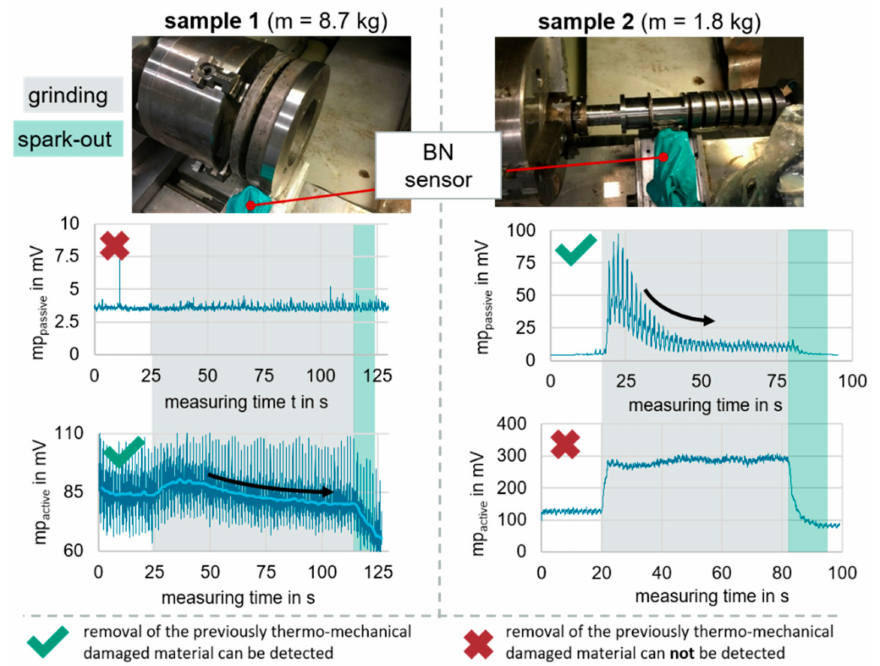
Figure 7. Active and passive Barkhausen noise measurements during grinding of different